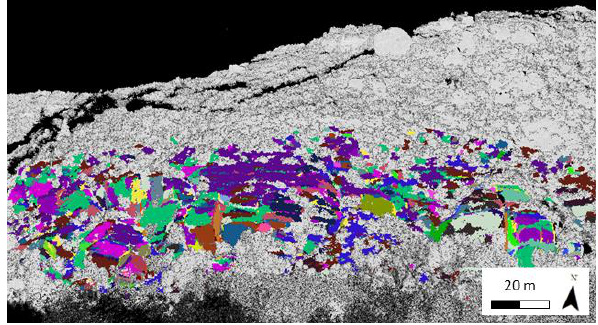
Figure 10. Visualization of plane sets in the area of interest fit into point cloud of scan position 01 4.4 Smoothing